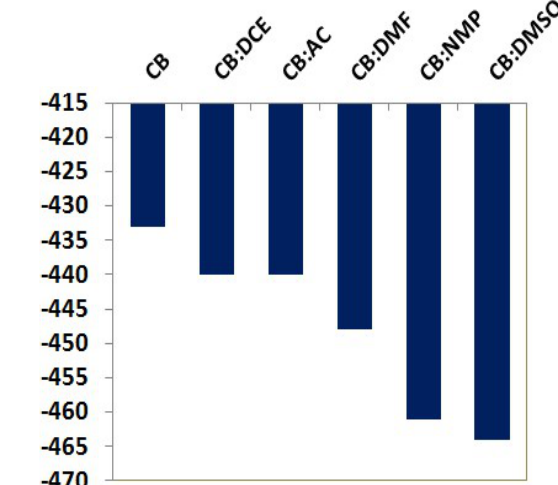
Figure 6. Seebeck coefficient values of the samples.